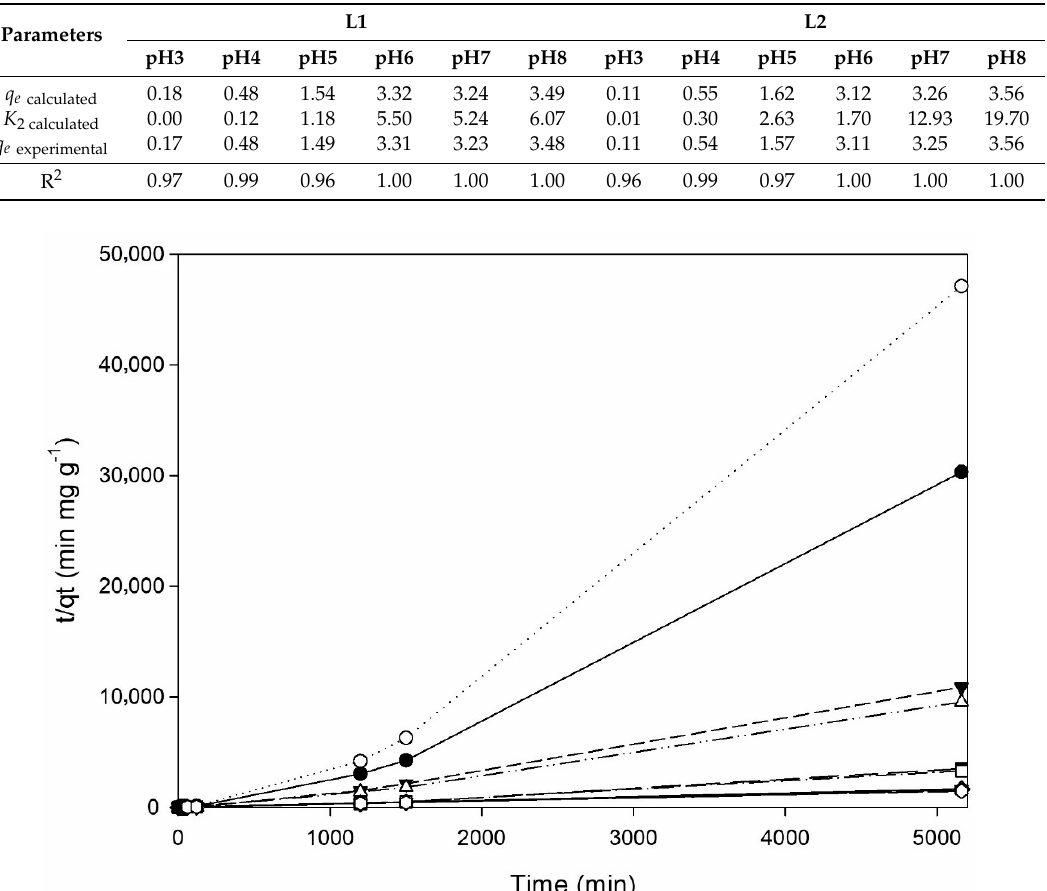
Figure 8. Percentage of CR removal at different pH for pH3 L1 (-●-); pH3 L2 ( … ○ … ); pH4 L1 (-- Figure 10. Pseudo-second order adsorption kinetics of CR for pH3 L1 (- ● -); pH3 L2 ( … ○ … ); pH4